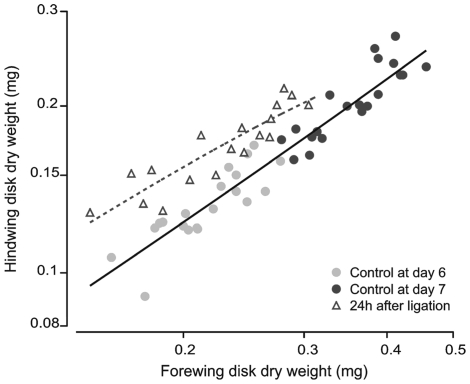
Effect of mid-thoracic ligation on fore- and hindwing imaginal disk growth.A ligation was placed between the second and third thoracic segment on the first day of the wandering phase (day 6). The ligation prevented the forewing from receiving most factors coming from the abdominal region, and also prevented the hindwing from receiving brain factors. The relationship between fore- and hindwing sizes for controls fall on a common regression. In ligated larvae (open triangles) the forewing disks grew little in 24 hours, and the hindwings grew about half as much as controls (black circles) The regression lines for control and ligated larvae for fore- vs hindwing disk sizes are statistically different (p<0.001).